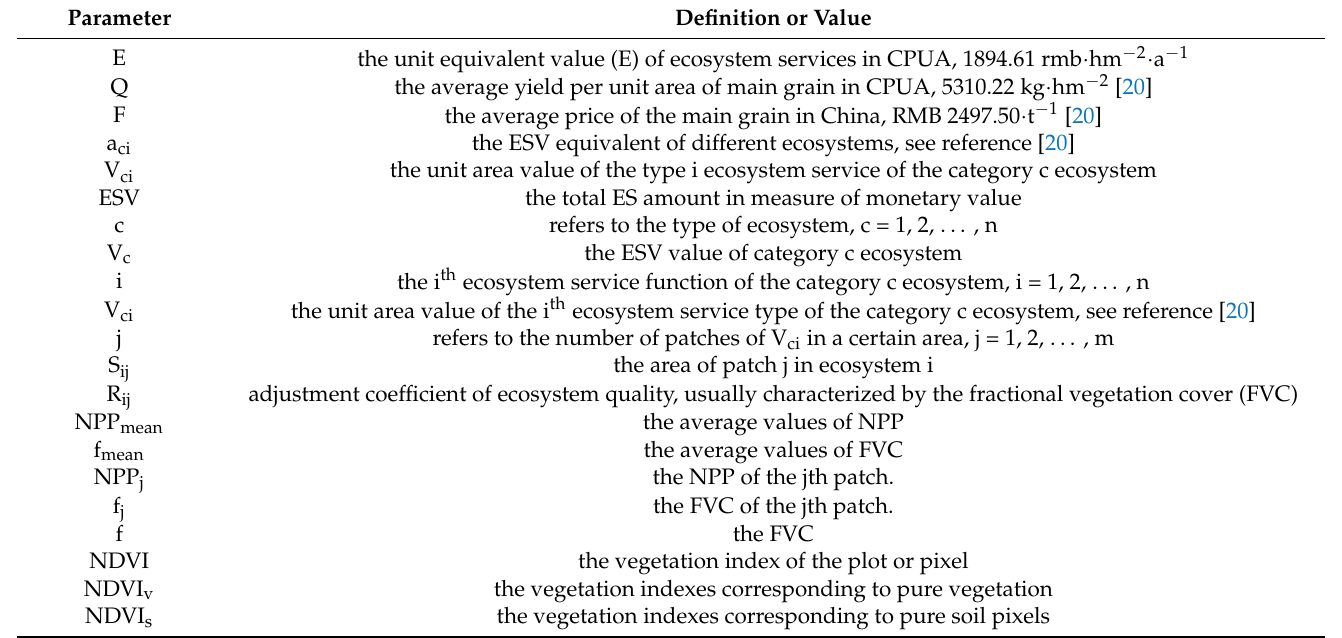
Table 3. Parameters and reference parameter values of ES calculation formulas.